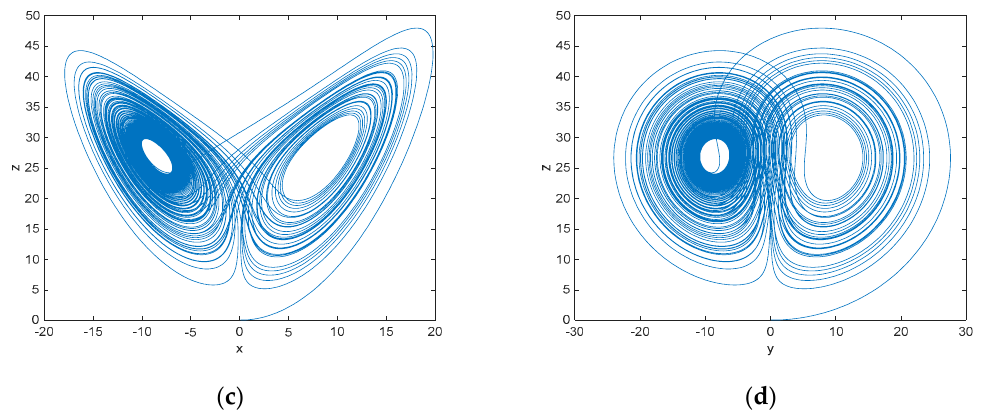
Figure 4. Phase space diagram of each plane. ( a ) x - y - z plane; ( b ) x - y plane; ( c ) x - z plane; ( d ) y-z plane.